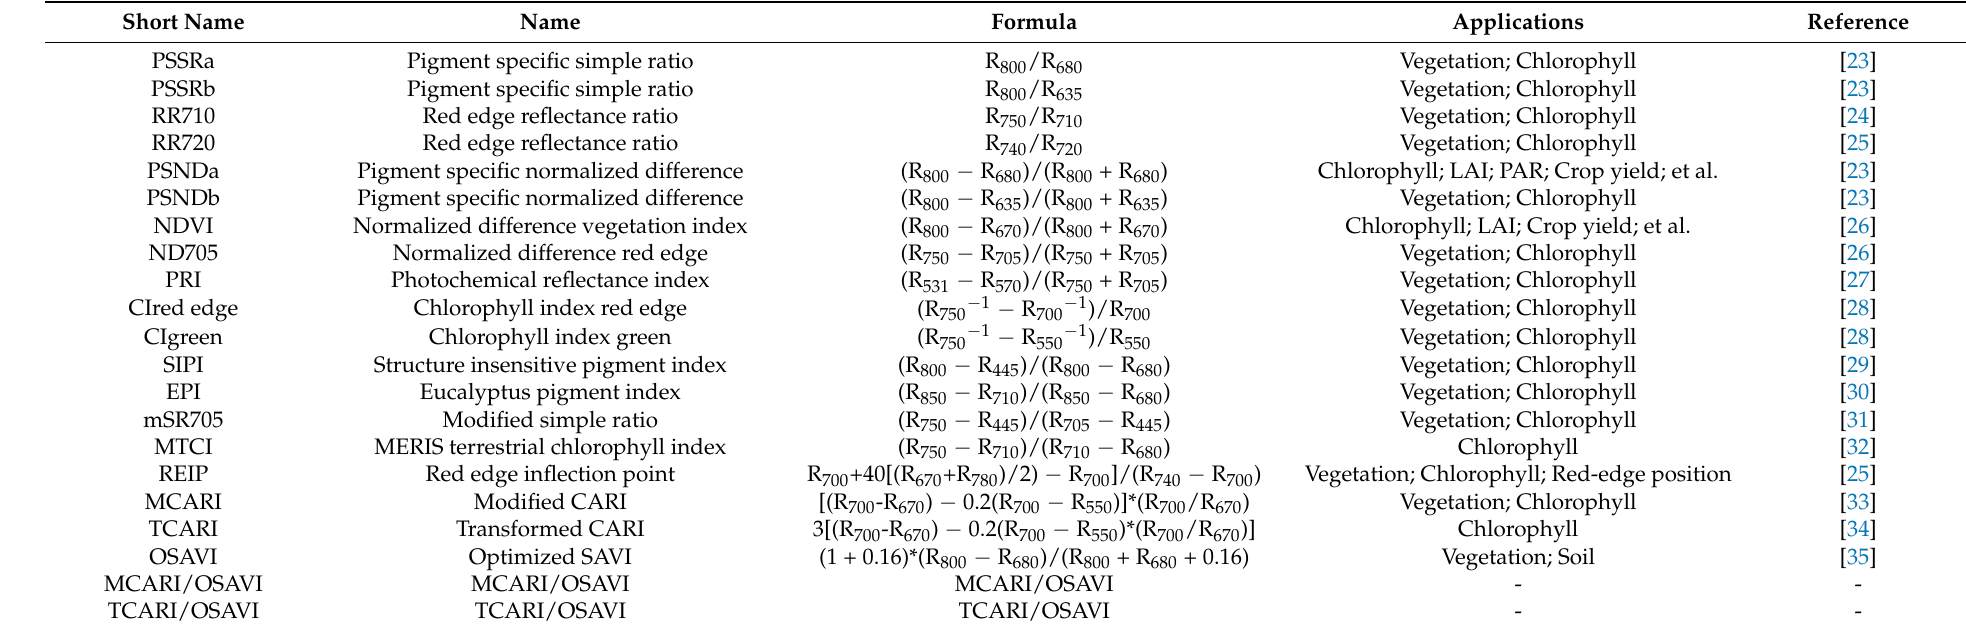
Table 1. Spectral vegetation indices employed in this